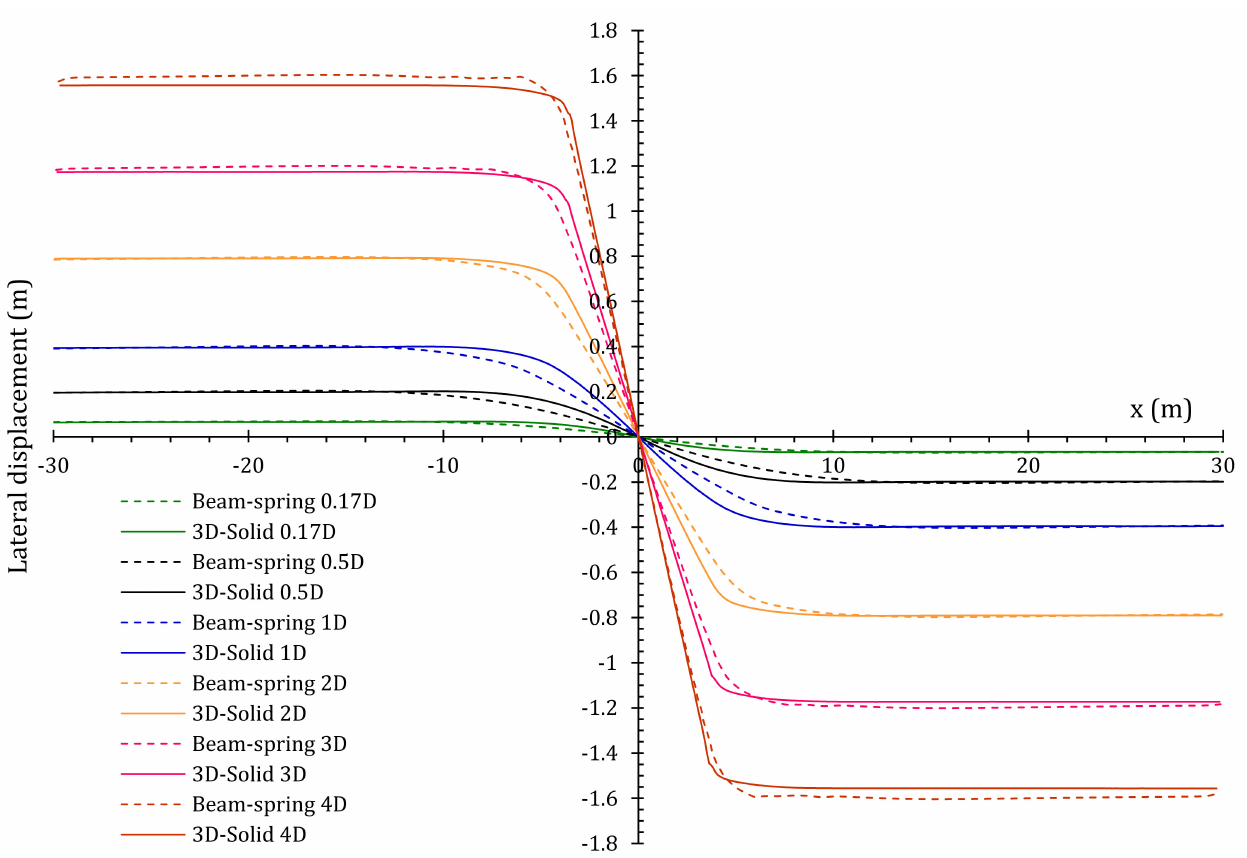
Figure 15. Lateral displacement of the buried pipeline subjected to a 60 ◦ strike-slip fault movement in the 3D solid model versus the beam–spring model on a crown/invert of a pipe cross-section, for cases with fault movements of 0.17D, 0.5D, 1D, 2D, 3D, and